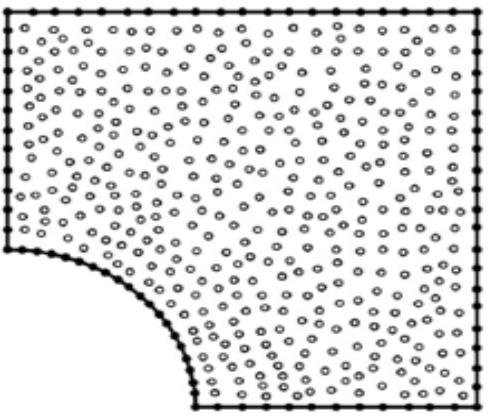
Figure 1. BEM modeling of the present problem.